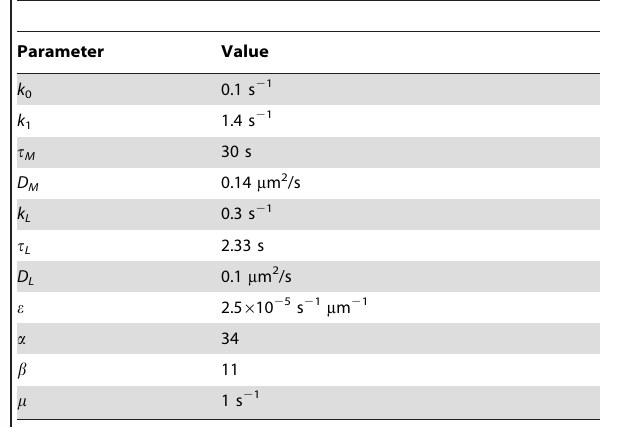
Table 1. Parameters used for simulations of the EC&M model.